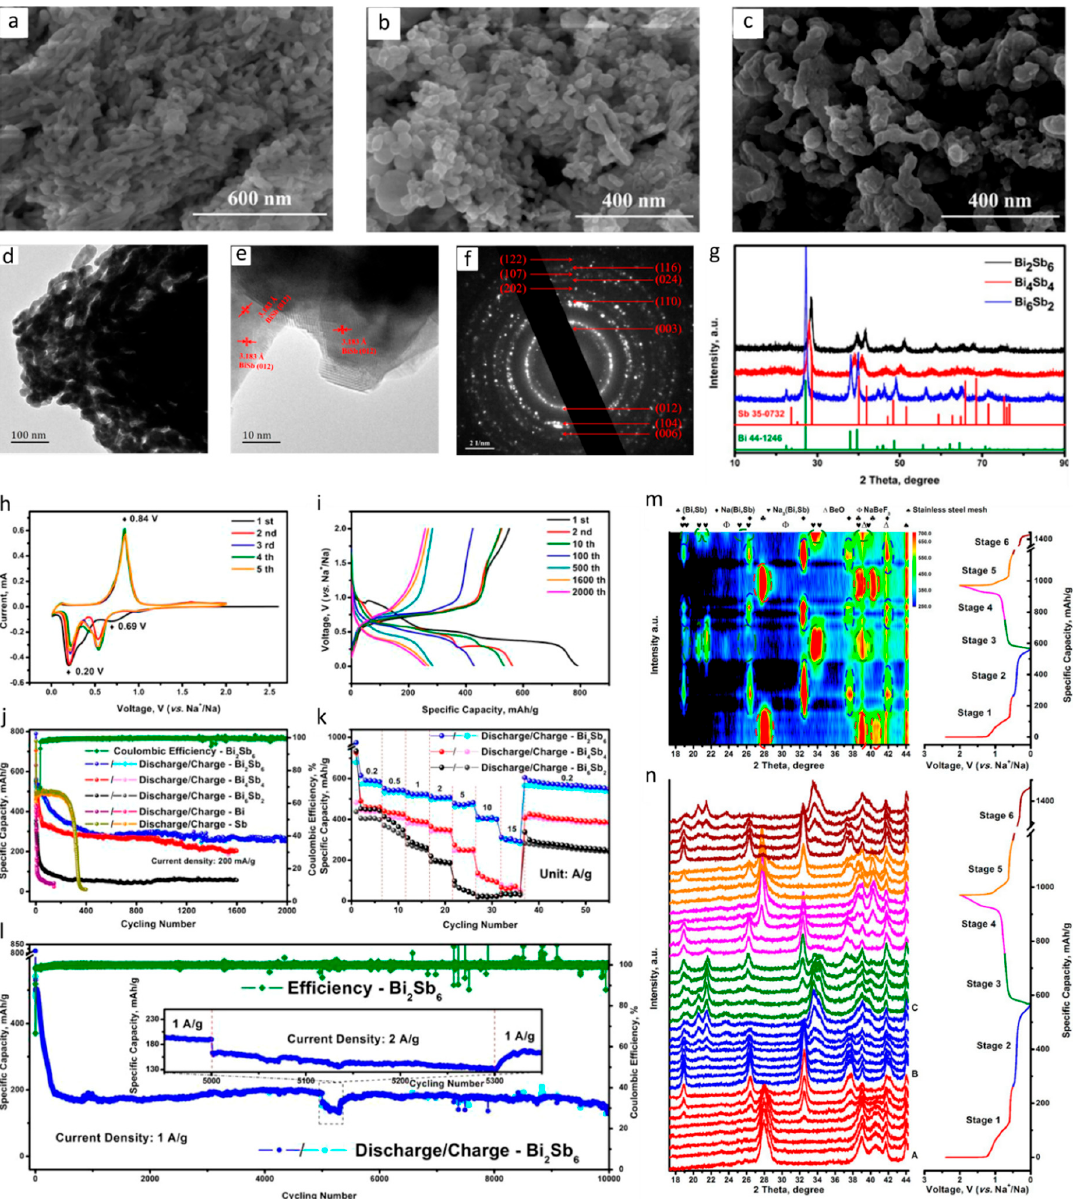
Figure 5. Structural characterization and electrochemical performance analysis of intermetallic alloy (np-Bi-Sb) as an anode in SIBs: ( a – c ) SEM images of the np-Bi 2 Sb 6 , np-Bi 4 Sb 4 , and np-Bi 6 Sb 2 samples, respectively showing typical three-dimensional bi-continuous ligament-channel with various size of ligaments. ( d ) TEM image of the np-Bi 4 Sb 4 features the nanoporous structure of np-Bi-Sb alloys. ( e ) The high resolution TEM (HRTEM) image shows that the crystal size (~25 nm) of the np-Bi-Sb alloys are approximately close to the ligament’s sizes. ( f ) The selected-area electron di ff raction (SAED) pattern of the np-Bi-Sb alloy further confirms the nanocrystalline structure of the selected region. ( g ) XRD patterns of the np-Bi-Sb alloys are indexed to the single phase of BiSb alloy. ( h ) Cyclic voltammograms (CV) of the np-Bi 2 Sb 6 electrode at a scan rate of 0.1 mV s − 1 over a potential window of 0.01 − 2.0 V (vs. Na + / Na). ( i) GCD curves of the np-Bi 2 Sb 6 electrode in di ff erent cycles at a current density of 200 mA / g. The overlap of the charge / discharge curves of the 1600th and 2000th cycles implies the excellent stability during the long cycling. ( j , k ) Excellent cycling performance and rate capability of the np-Bi-Sb alloys, respectively. ( l ) Cycling performance and coulombic e ffi ciency of the np-Bi 2 Sb 6 electrode at 1 A g − 1 exhibit amazing cycling capability. A zoom-in image (inset) illustrates the cycling performance at 2 A g − 1 when the discharge capacity can remain about 150 mAh g − 1 from 5000 to 5300 cycles. ( m – n